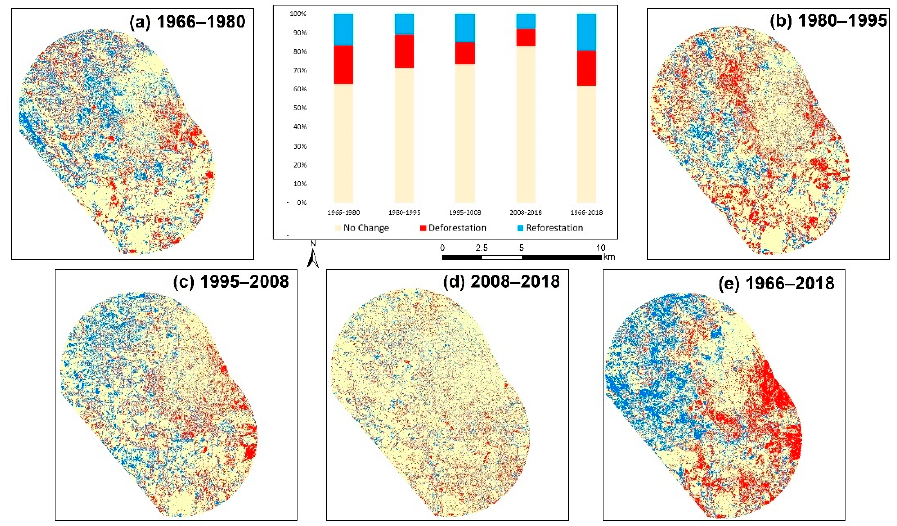
Figure 3. Transition changes in forest cover for the periods of 1966–1980 ( a ), 1980–1995 ( b ),